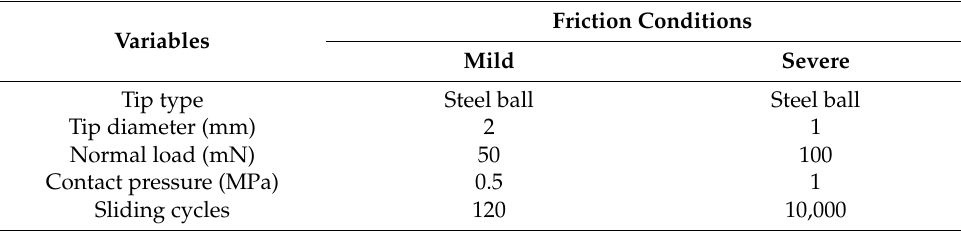
Table 1. Experimental conditions of the friction test.